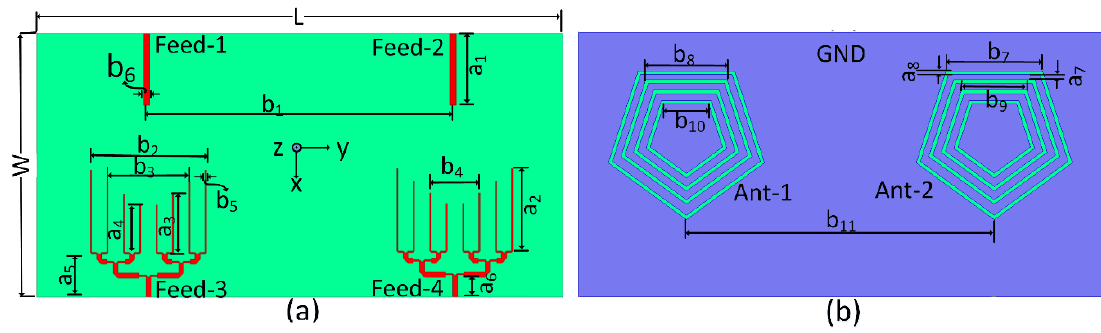
Figure 1. Proposed MIMO antenna: ( a ) Top layer, ( b ) GND plane.